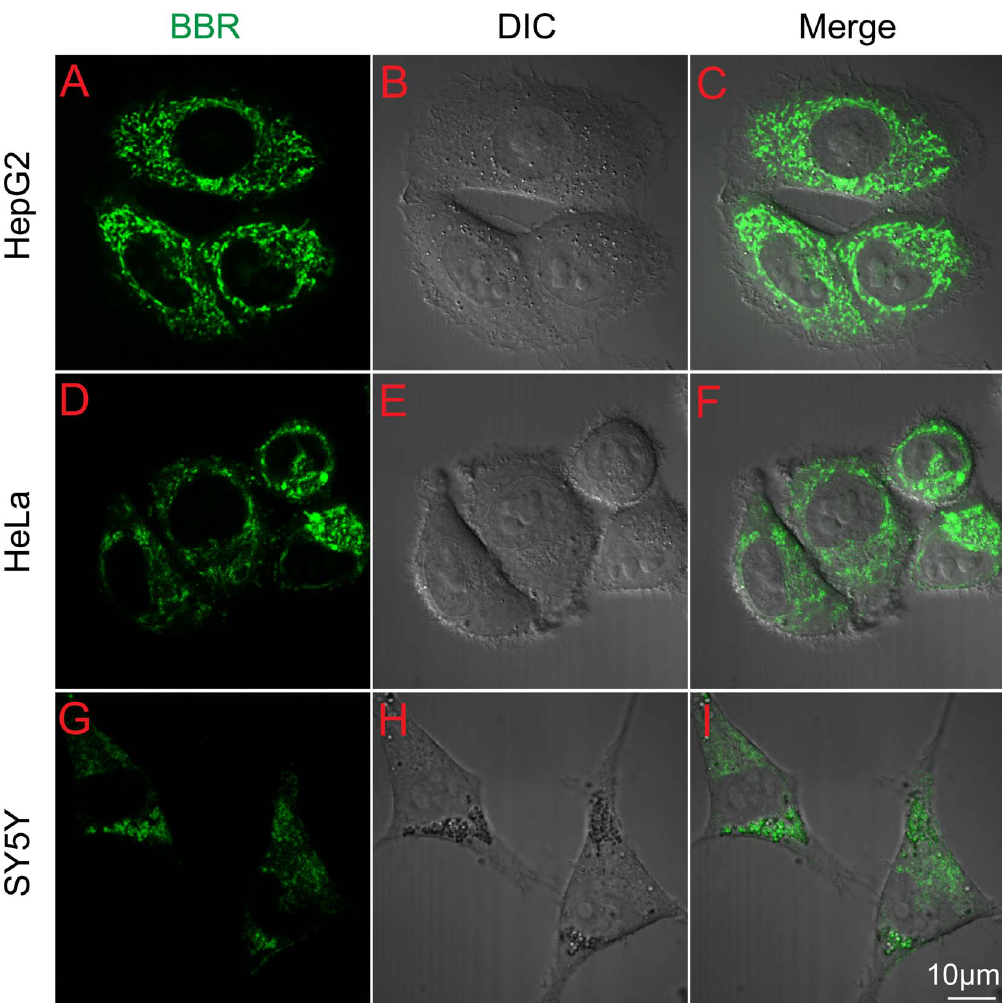
Figure 2. Transportation of BBR through the cells. (A–I) Images of the subcellular location of BBR in cells before and after 0.5 m g/ml BBR administration for 1 h. (A–C) HepG2 cells; (D–F) HeLa cells; (G–I) SY5Y cells. The fluorescence of BBR is shown in green, differential interference contrast (DIC) figures represent the scale of cells and scale bar is 10 m m.